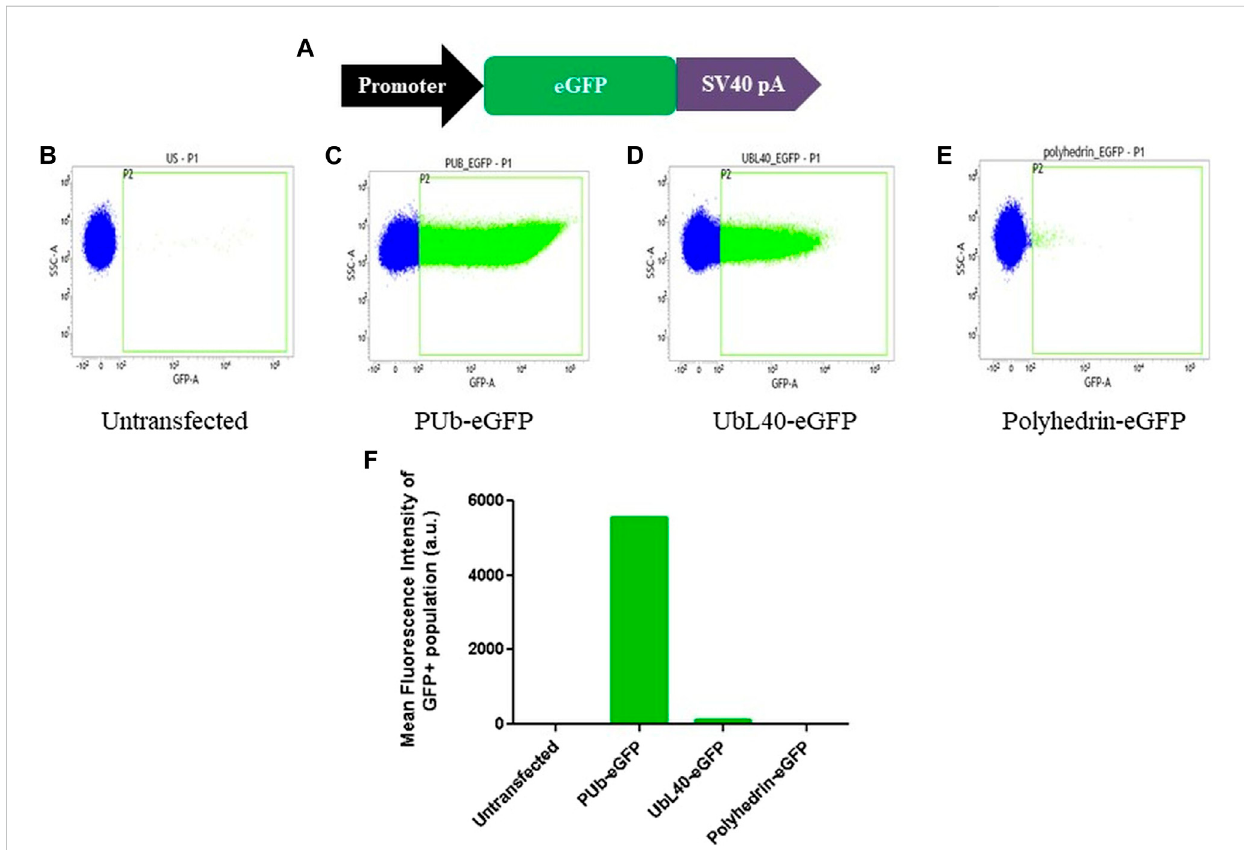
Evaluation of promoter activity in Aedes cells. (A) Schematic diagram of the design of fl uorescent reporter cassettes to evaluate promoter activity. (B – E) Flowcytometry analysis oftheuntransfected (B) cellsandcellstransfectedwitheGFPgeneunderthecontrol ofPUb (C) ,UbL40 (D) andpolyhedrin (E) promoters. The histogram plot showing the mean fl uorescence intensity of the GFP positive cells is shown in (F)